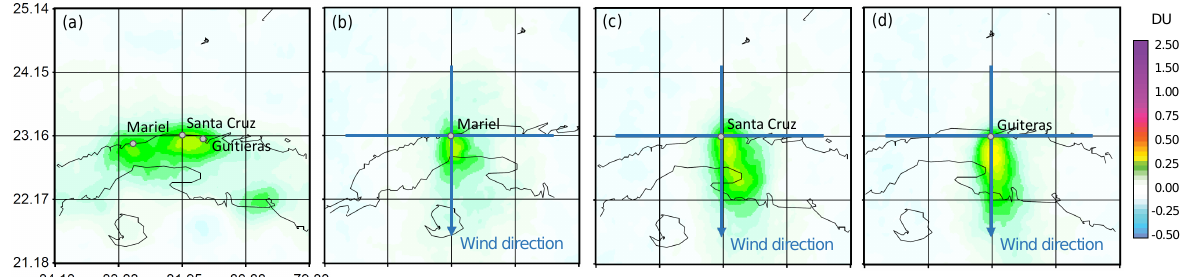
Figure 5. (a) Mean SO 2 distribution near Santa Cruz (Este de la Habana power plant), Mariel (Máximo Gómez power plant), and the Antonio Guiteras power plant, Cuba, for 2005–2007. These power plants use Cuban domestic sulfur-heavy oil. Mean SO 2 distributions near (b) Mariel, (c) Santa Cruz, and (d) Guiteras after the wind rotation procedure was applied to each site.